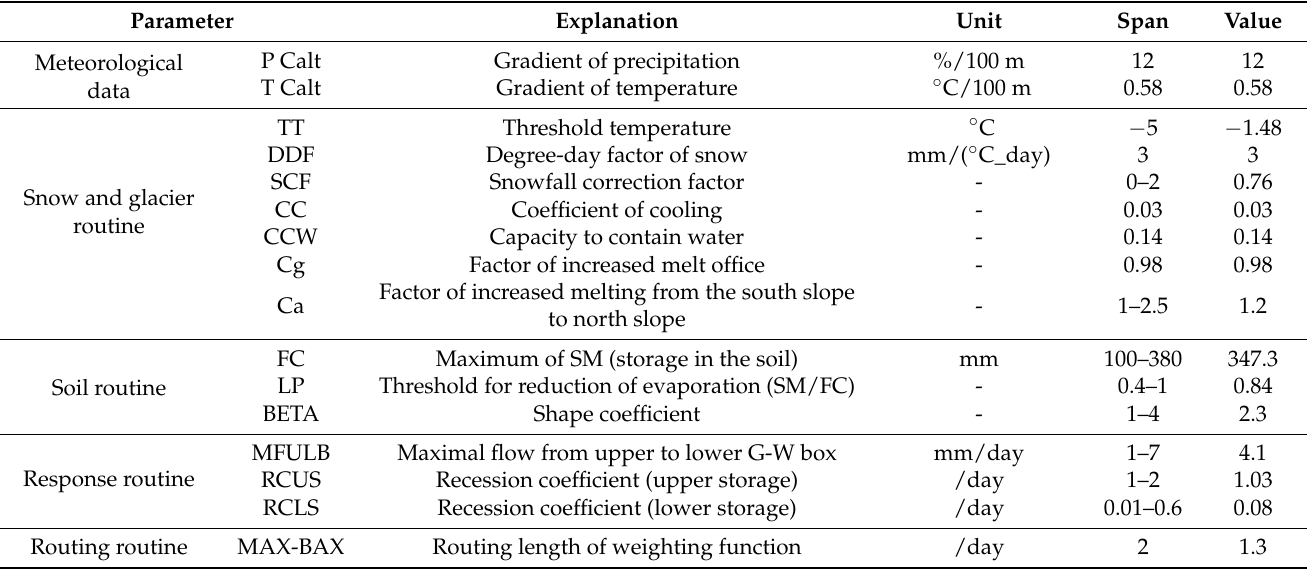
Table 1. HBV model parameters for the Kunhar River